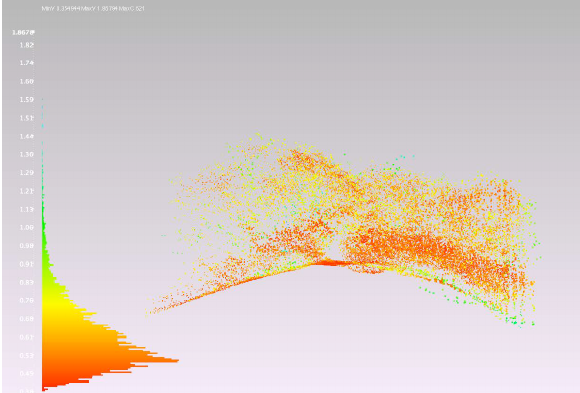
Figure 12. Local densities of the unsegmented point cloud